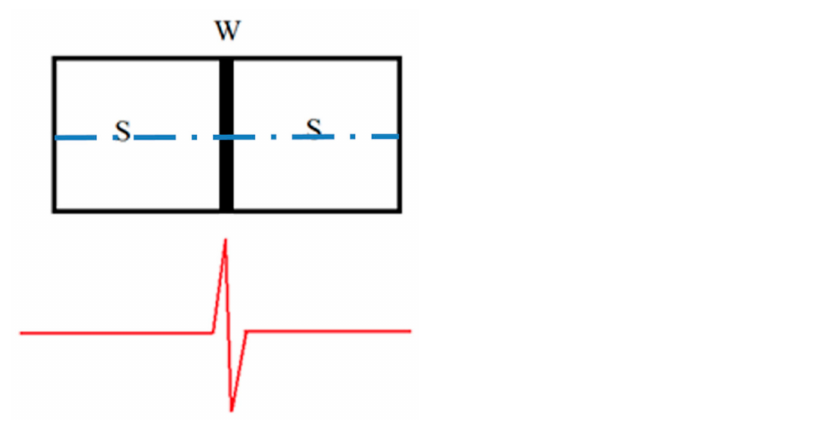
Figure 7. The concept of the elementary block with disturbance